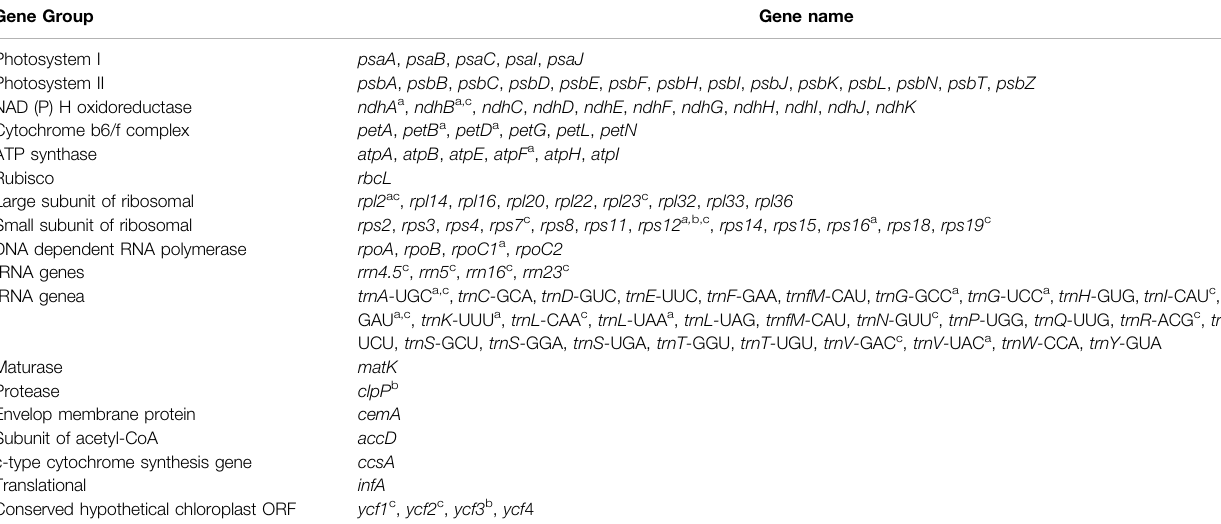
TABLE 2 | Genes in the chloroplast genome of Crataegus chungtienesis.